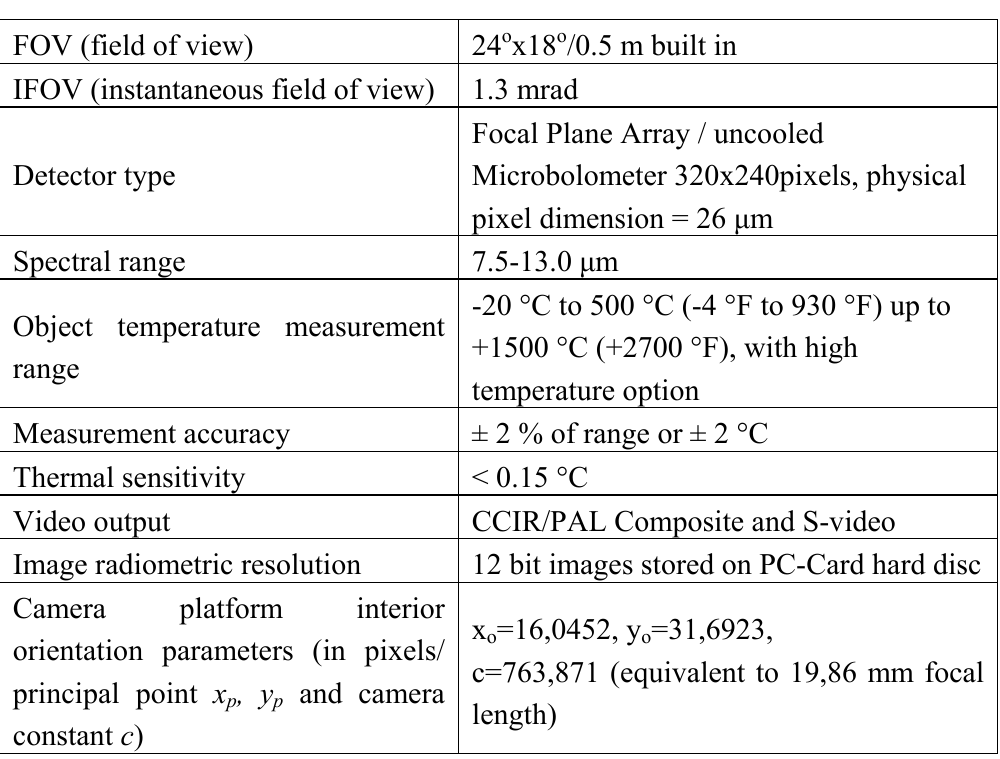
Table 1 . AGGA Thermovision R570 Infrared camera